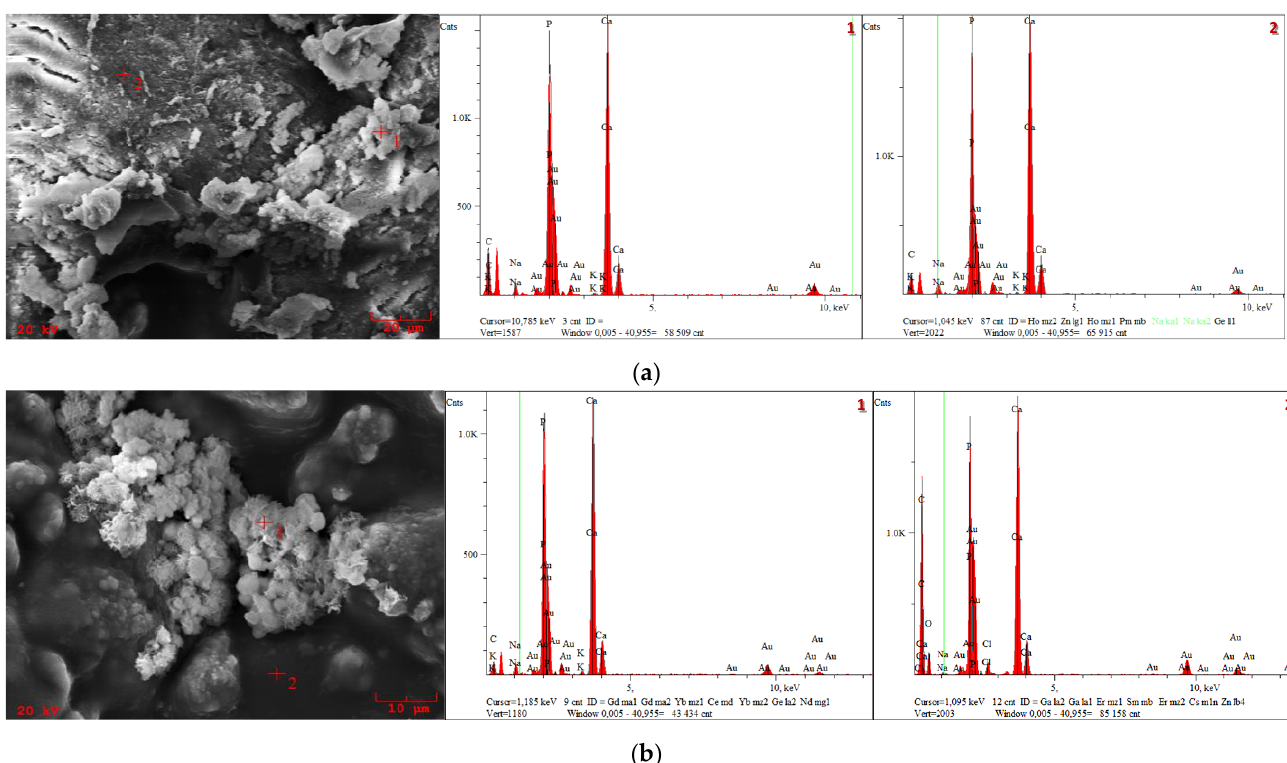
Figure 7. SEM morphology and EDS microanalysis of the composites: ( a ) 17.2; ( b ) 25.2.